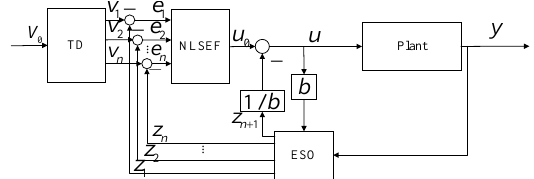
Figure 5. Traditional ADRC control